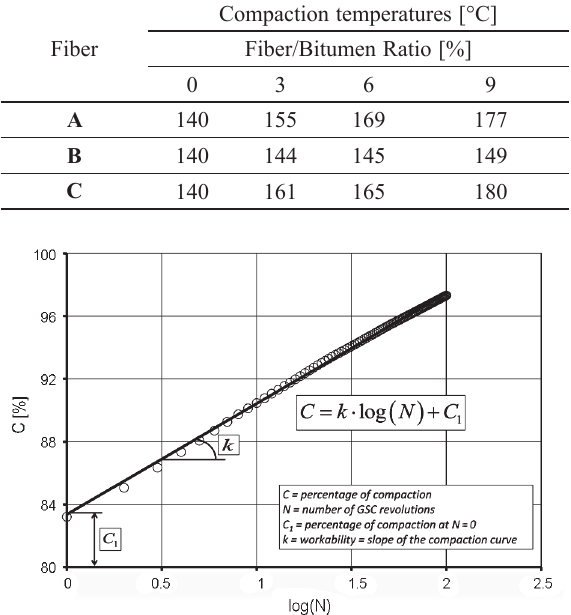
Fig. 3. Example of the estimation method used for the compaction temperatures Fig. 4. Typical gyratory shear compactor test